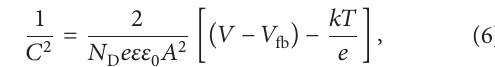
Figure 6: Temperature dependence of charge carrier concentration for the investigated CdS/Si heterojunction before and after 𝛾 - irradiation with different doses.